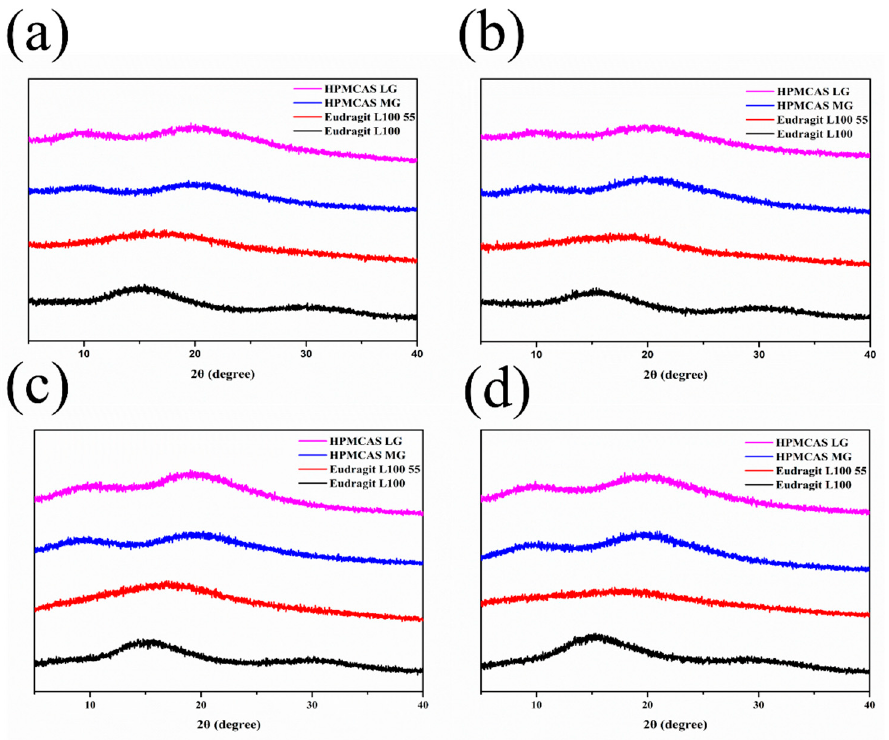
Figure 11. PXRD of ASDs at 92.5% ± 5% humidity and 60 °C ± 1 °C temperature. ( a ) 5 days (humidity), ( b ) 10 days (humidity), ( c ) 5 days (temperature), ( d ) 10 days (temperature).